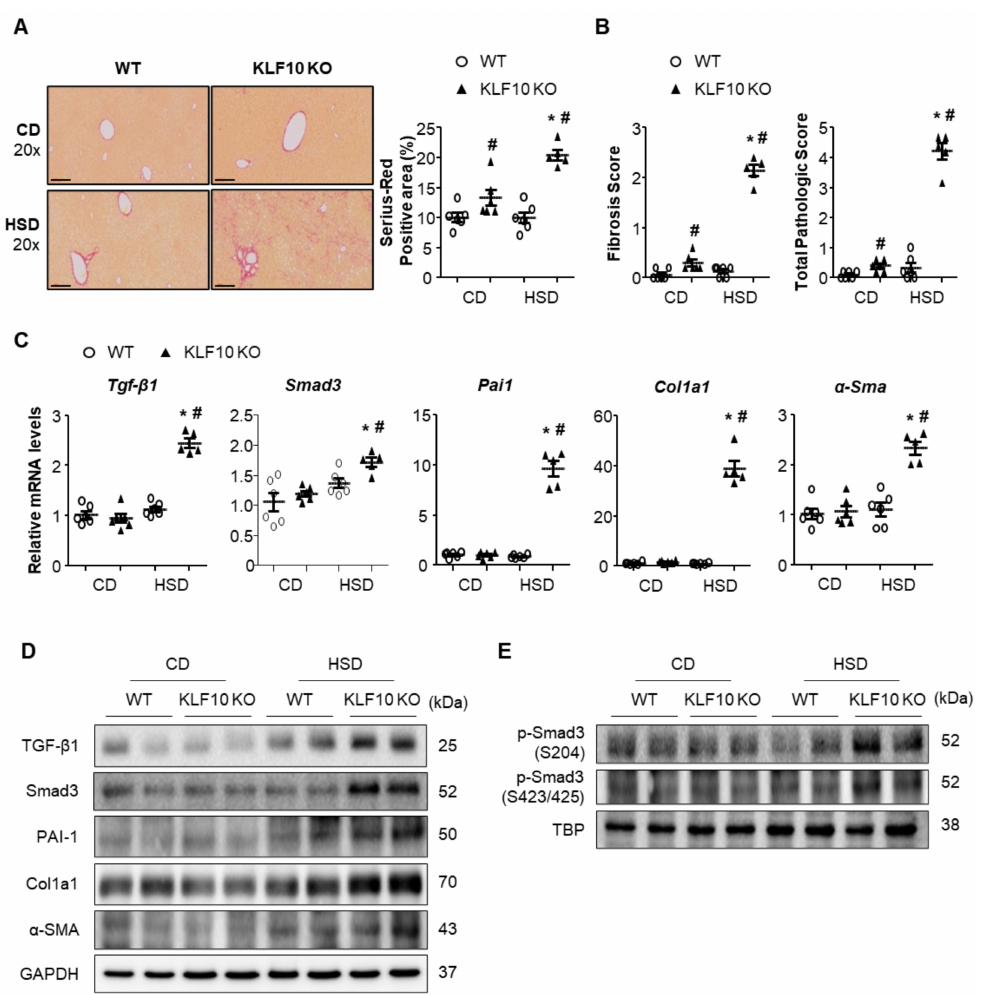
Figure 6. Klf 10 deletion aggravates liver fibrosis through the activation of TGF- β -Smad3 pathway. Eight-week-old WT and Klf 10 KO mice were fed either CD or HSD for eight weeks (n = 5–6 mice/group). ( A ) Collagen deposition was evaluated via Sirius Red staining of the liver sections (Scale bars: 60 µ m, Magnification: 20 × ). Quantification indicates Sirius Red-positive area (percentage). ( B ) The grade of the fibrosis and NASH score was calculated. Changes in hepatic mRNA and protein expression involved in TGF- β (TGF- β 1 and Smad3) and fibrogenesis (PAI-1, α -SMA, and Col1A1) pathway were analyzed via ( C ) qPCR and ( D ) Western blotting. ( E ) Nuclear extracts were used to detect the phosphorylation levels of Smad3 at S204 and S423/425. A TATA-binding protein (TBP) was used as a nuclear loading control. All data are representative of at least three independent experiments and expressed as mean ± SEM. Charts were produced using GraphPad Prism 5.0. Statistical differences were determined by two-way ANOVA with Mann–Whitney U test using SPSS v17.0. * p < 0.05 vs. genotype-matched, CD-fed group and # p < 0.05 vs. diet-matched, genotype control. WT, wild type; KO, knockout; CD, control chow diet; HSD, high-sucrose